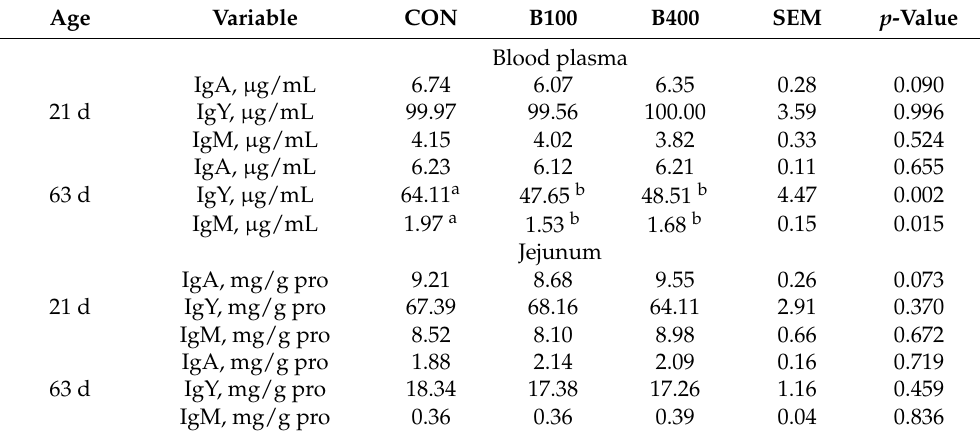
Table 4. Effects of dietary supplementation with bilberry extract on the content of immunoglobulin of yellow-feathered chickens 1